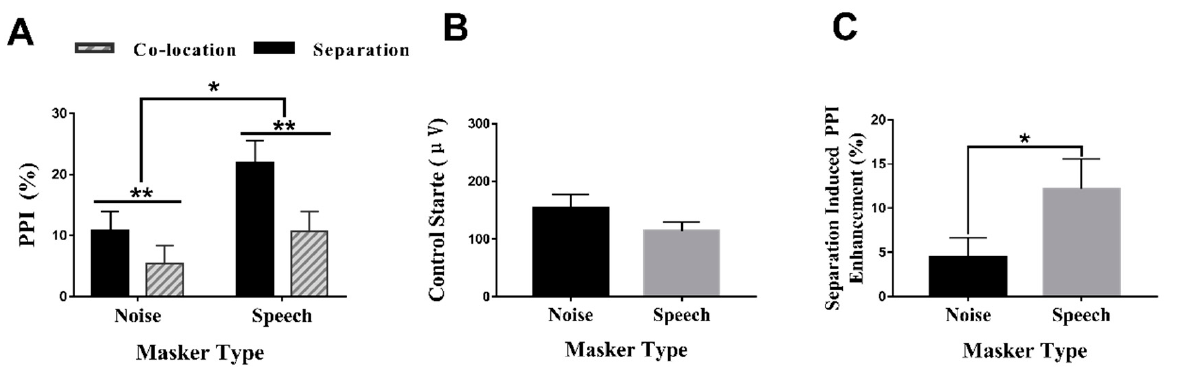
Figure 2. ( A ) Comparisons of PPI (%) across 29 participants under the four conditions. ( B ) Comparisons of control startle reactivity (no prepulse) across 29 participants under two masking conditions. ( C ) Comparisons of separation-induced PPI enhancement across 29 participants under two masking conditions. Formula: separation-induced PPI enhancement = PPI separation—PPI co-location. Data are expressed using mean ± SEM. *, p < 0.05, **, p < 0.01.